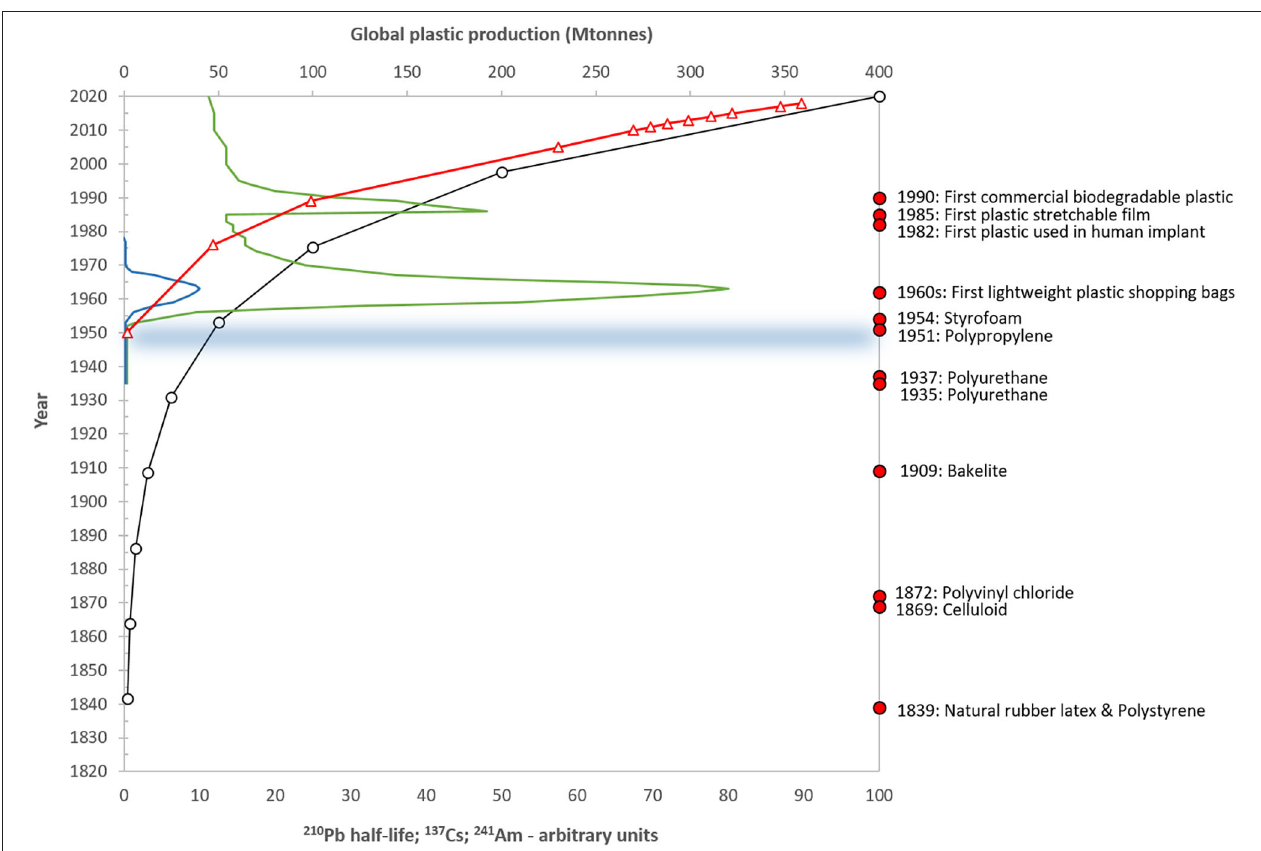
FIGURE 1 | Schematic diagram showing the timescales of radiometric dating techniques for natural archives, including the decay of the natural isotope 210 Pb (half-life 22.23 years; open circles); the 1963 nuclear weapons bomb-testing peaks of 137 Cs (green line) and 241 Am (blue line); and the Chernobyl reactor accident in 1986 ( 137 Cs). The global production of plastics in millions of tons is also shown (red triangles) (data from Plastics Europe, 2012, 2016, 2019) along with selected moments in plastic production history (taken from Crawford and Quinn, 2016) and the start of the proposed Anthropocene Epoch in circa. 1950 (horizontal